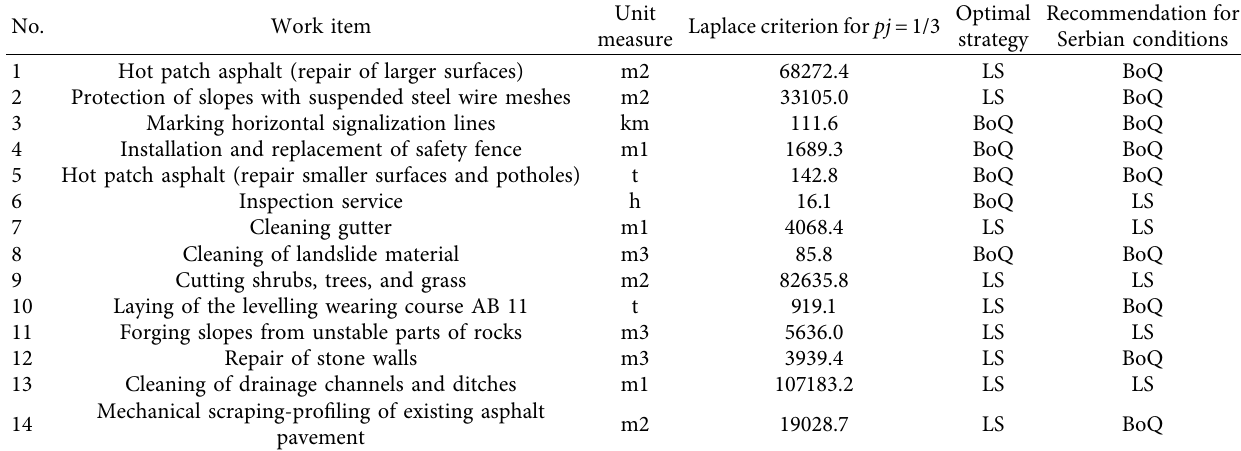
Table 7: Overview of optimal strategies using the Laplace criterion ( pi � 1/3) for selected works.